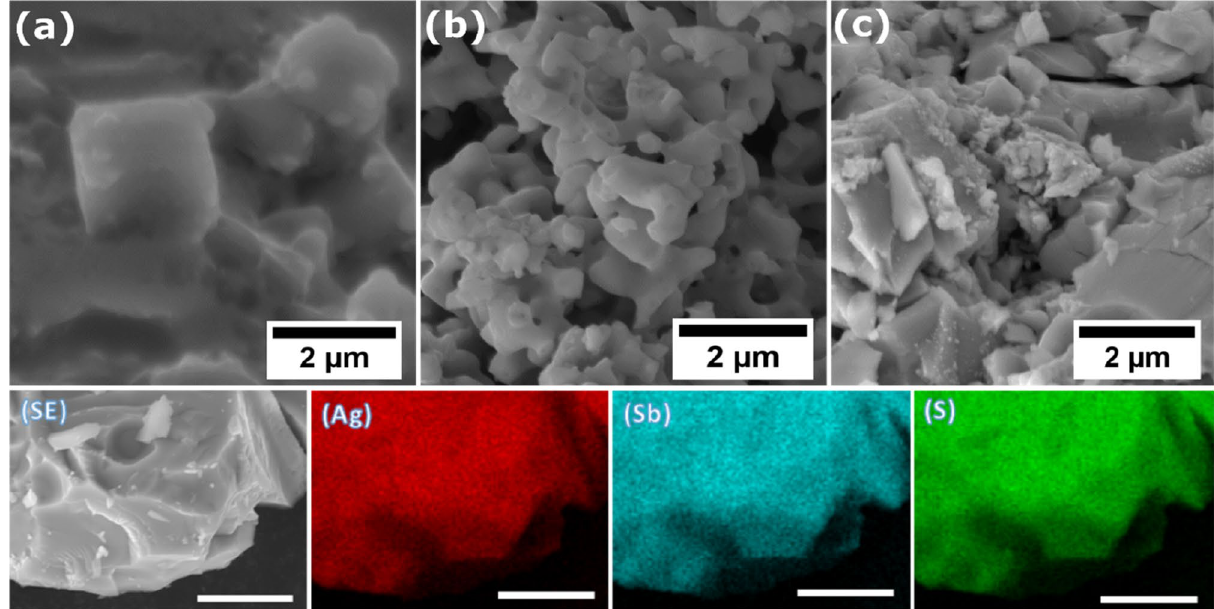
Figure 6. Top: SEM images of AgSbS 2 powders produced at ( a ) 400, ( b ) 450 and ( c ) 500 °C, respectively. Bottom: EDX elemental maps revealing the distribution of Ag, Sb and S elements at the microscale for AgSbS 2 produced at 500 °C (Ag Kα, Sb Kα and S Kα). The unlabelled scale bars represent 10